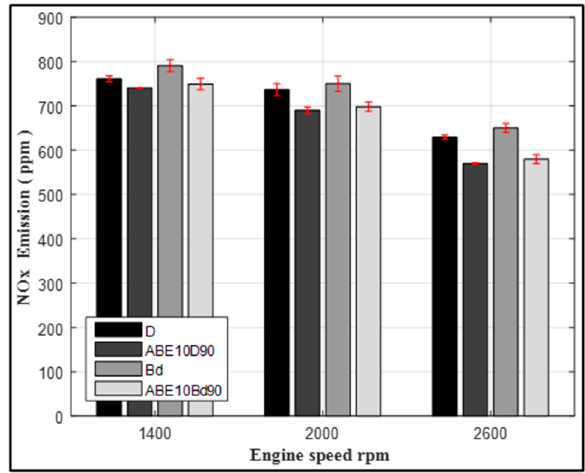
Figure 11. NO x emissions of test fuels.